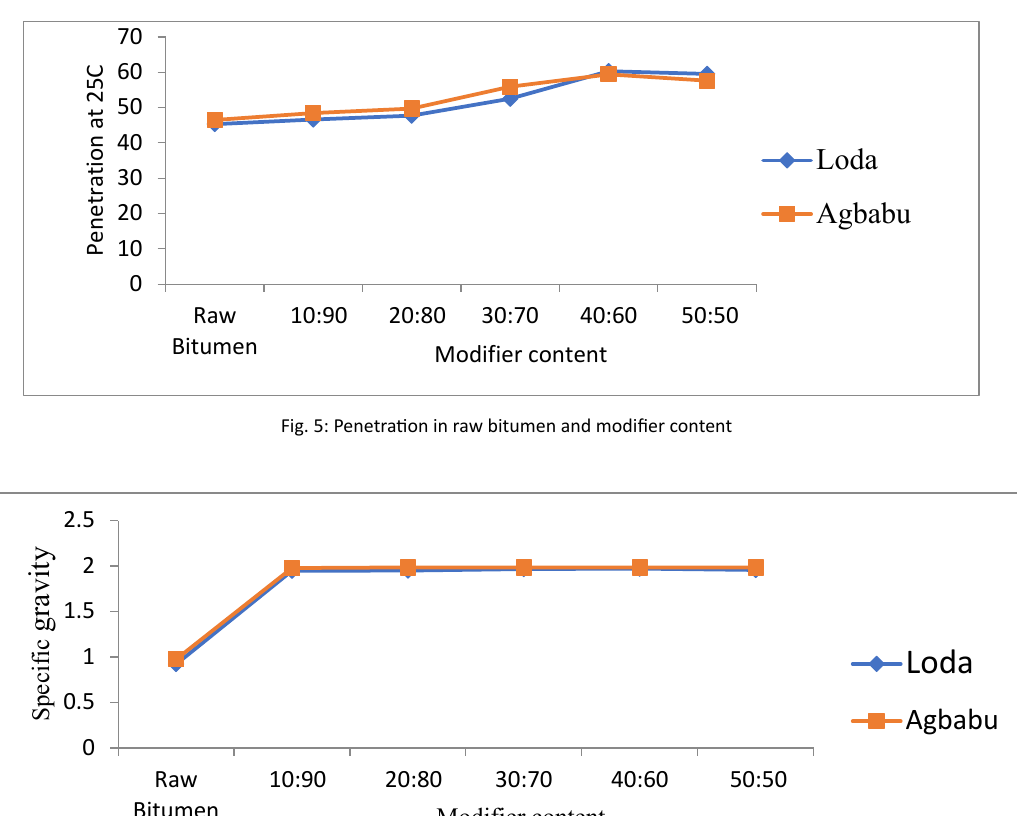
Fig. 6: Specific gravity in raw bitumen and modifier content